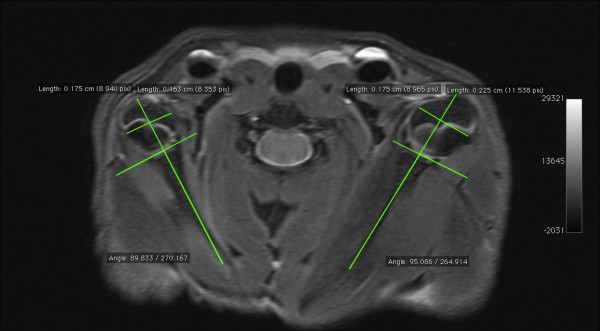
Shoulder MRI 8 weeks after surgery showing symmetrical measures of glenohumeral joint alignment: glenoid version and PHHA. This rat model does not reproduce the joint luxation found in children.